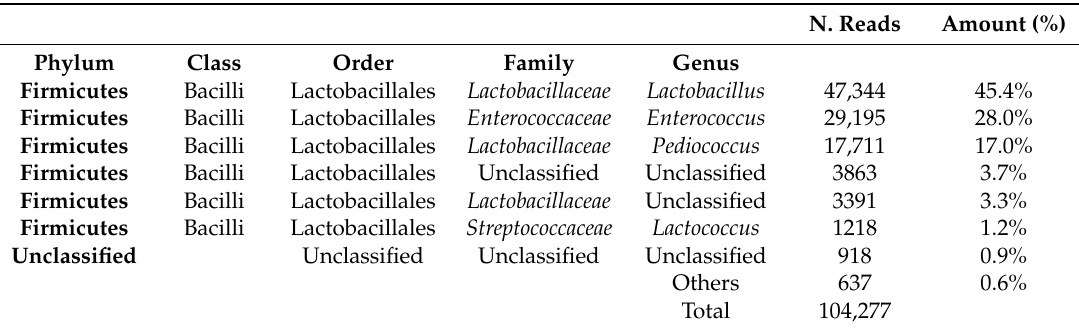
Table 3. Microbial composition of Lisosan ® G (LG 1 ). Number of sequenced reads and amount (%) of identified taxa were reported.